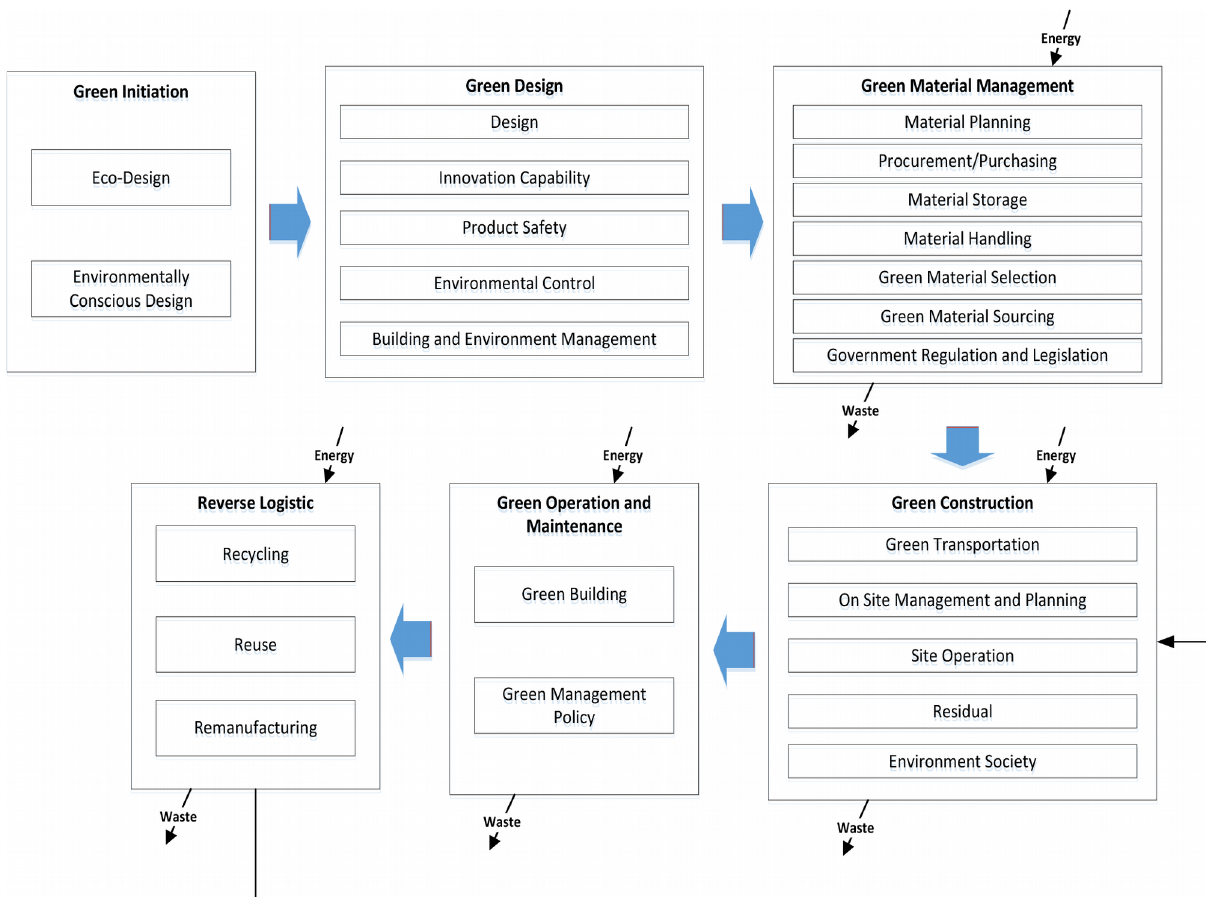
Figure 2. Framework of green supply chain processes for implementation in the construction industry (Ghobakhloo et al., 2013) The framework of green supply chain process implementation in the construction industry is explained in greater detail